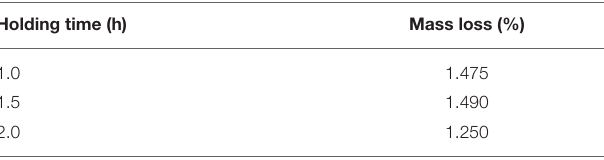
TABLE 2 | Mass losses of sisal hemp pulp-based paper at 400 ◦ C with different holding times (1.0, 1.5, and 2.0h). Holding time (h)